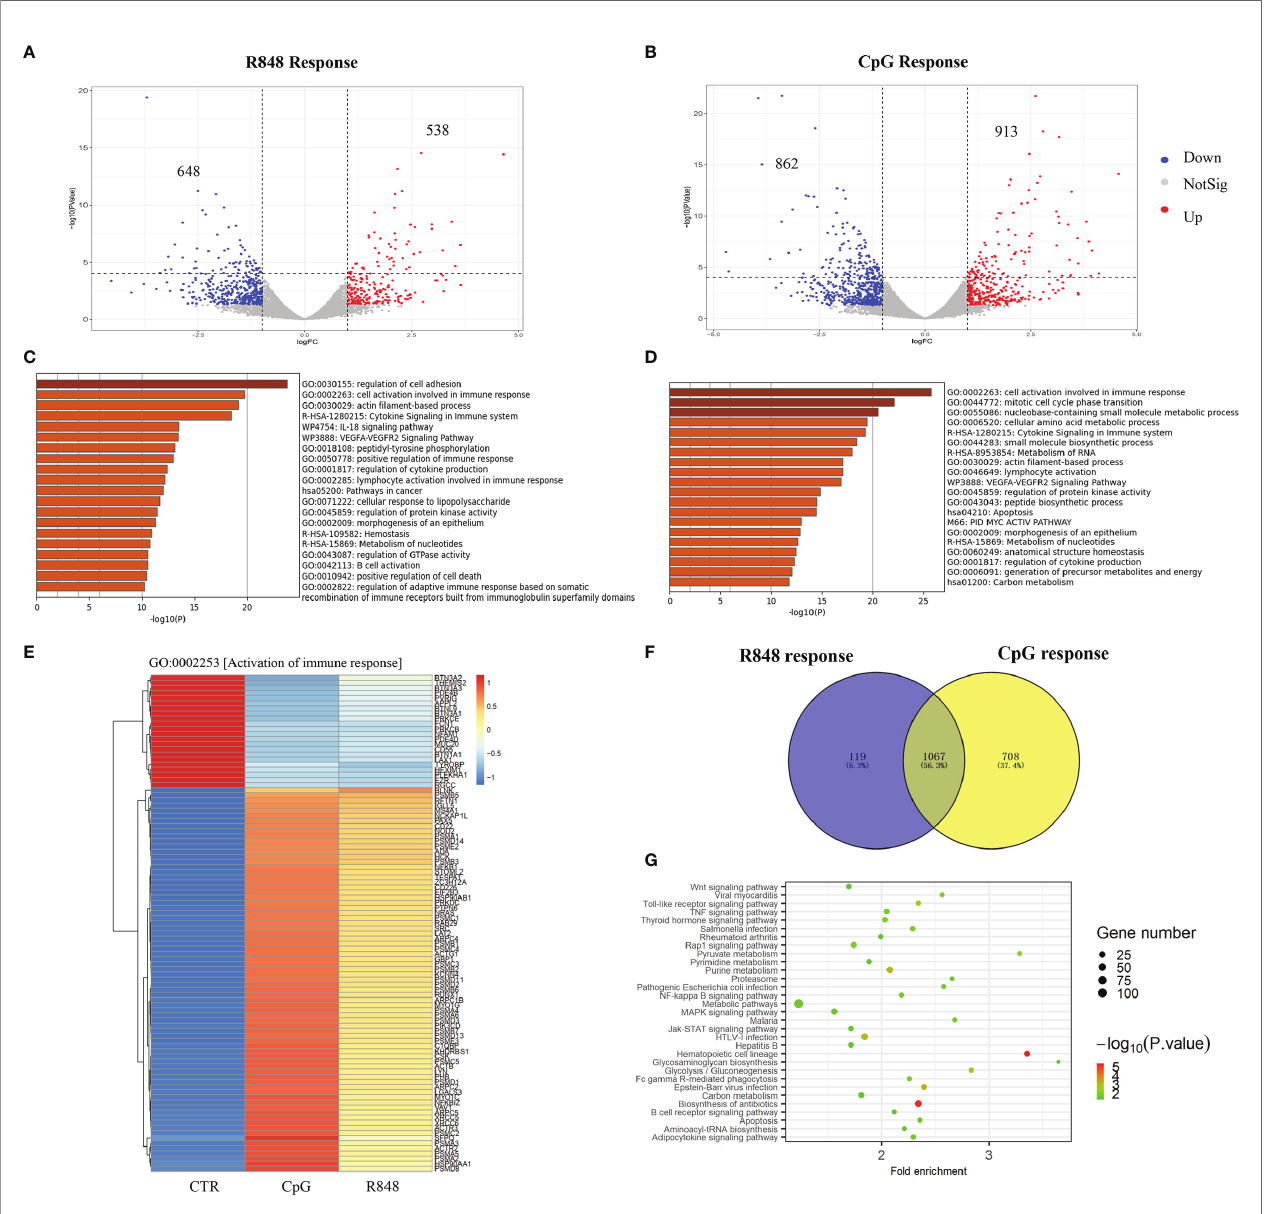
FIGURE 3 | Transcriptome sequencing in TLRs induced response in B cells. RNA-seq with triple biological repeats was performed on untreated, R848-treated and CpG-treated puri fi ed B cells from three healthy donors. Volcano plot showing 1,186 differentially expressed genes (DEGs) in B cells upon R848 stimulation (A) and 1775 DGEs upon CpG stimulation (B) . Metascape software was use to perform functional annotation of DEGs induced by R848 stimulation (C) and CpG stimulation (D) . (E) Heatmap showing the DEGs in the biological progress gene ontology (GO) term “ Activation of immune response ” . (F) Venn diagram showing the overlap of DEGs induced by R848and CpG stimulation. (G) Visualization and Integrated Discovery (DAVID) was used to analyze Kyoto Encyclopedia of Gene and Genome (KEGG) pathway of DEGs overlapped in response to R848 and CpG